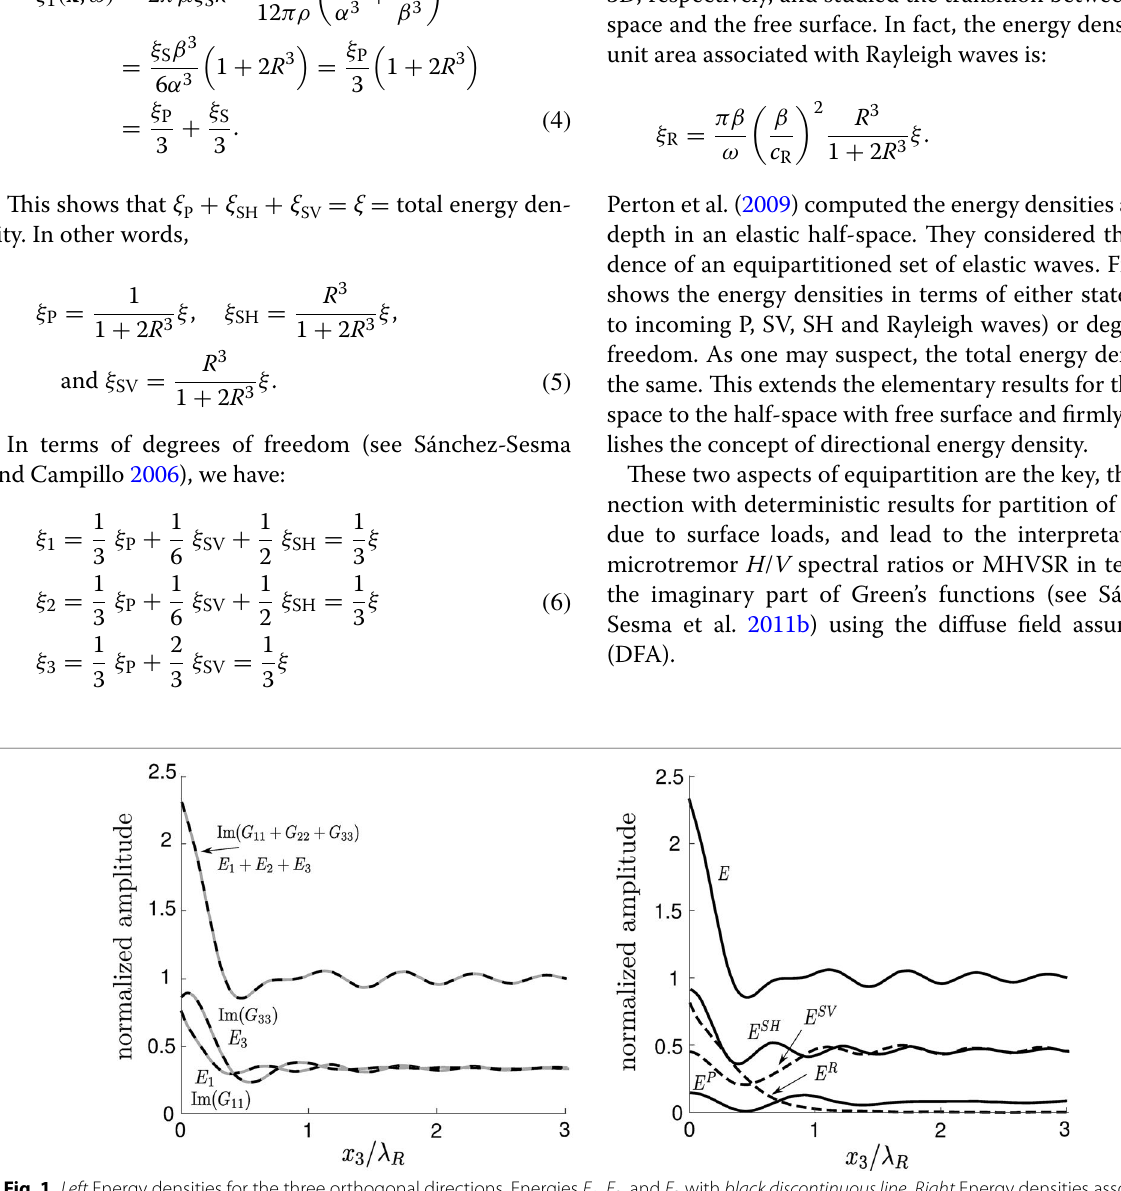
vertical coordinate pointing toward the =